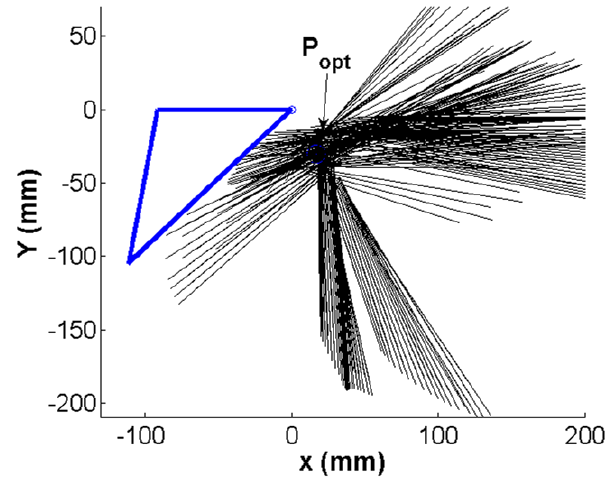
Figure 2. Typical example of the calculated instantaneous helical axes for Cir, Abd, and FE motions in the xy -plane. Selected axes are plotted for each motion dataset. P opt : the optimal pivot point (the kinematic GH-JRC calculated using the IHA- method).